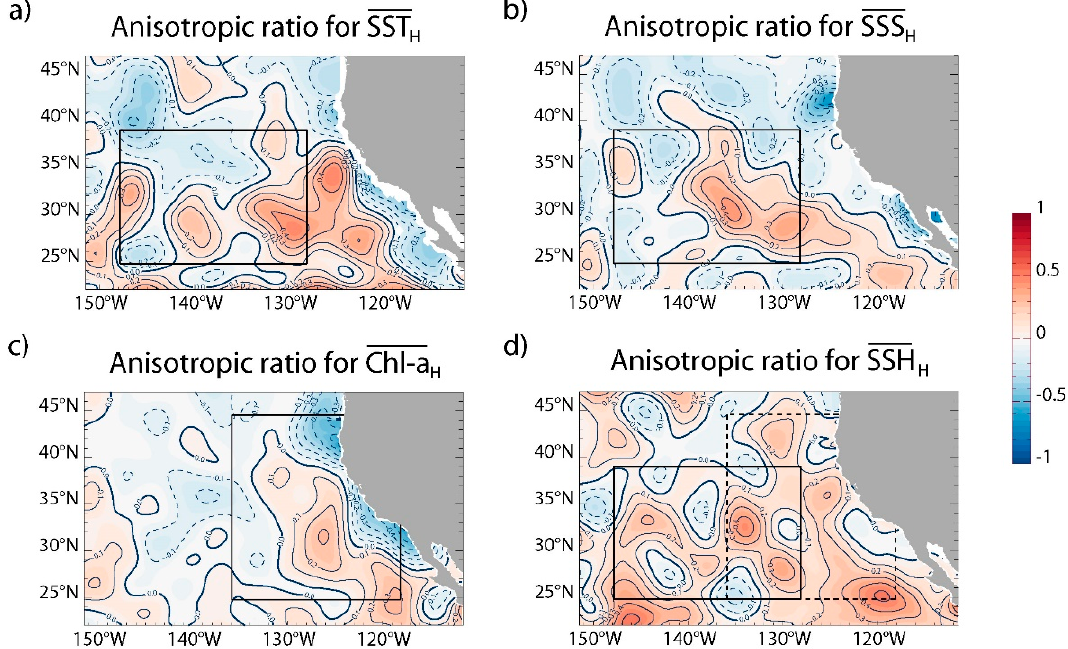
Figure A1. Anisotropic ratio for the spatially high-pass filtered time-averaged ( a ) AMSR-2 SST, ( b ) SMAP SSS, ( c ) GlobColour